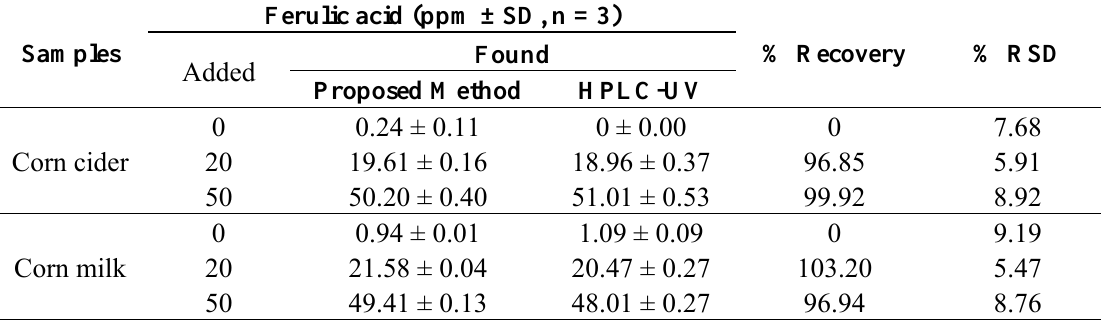
Table 1. Determination of ferulic acid levels (ppm) in real samples using the proposed paper-based device with electrochemical detection, compared to that derived using the conventional HPLC-UV. Data shown are the mean ± 1 SD derived from three independent repeats. No significant difference ( p > 0.05) was found between the two methods in all